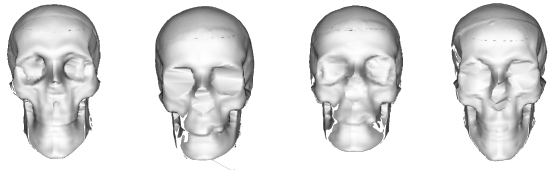
Figure 3. Skull 3D models from unpaired dataset